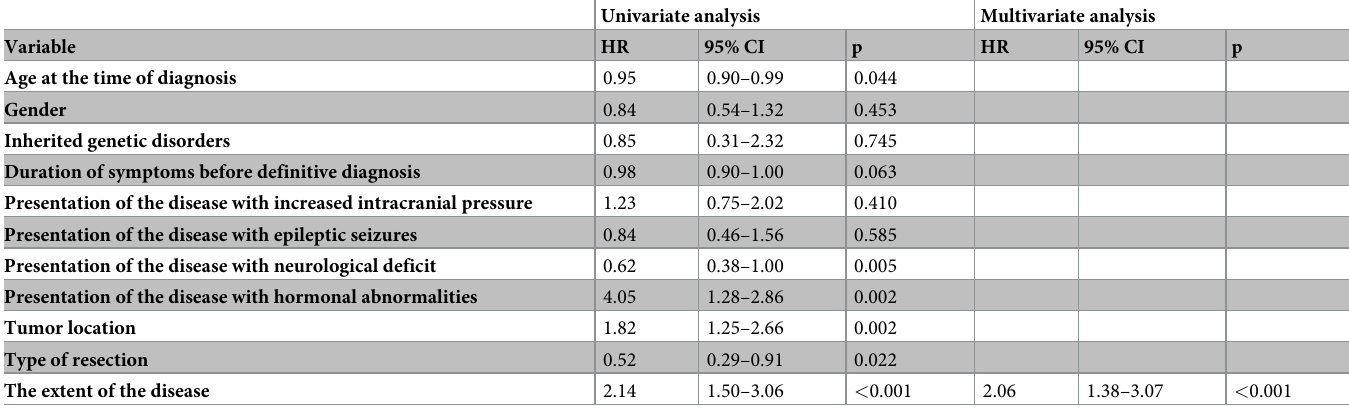
Table 2. Predictive factors of OS in 173 pediatric patients with brain tumors–Cox proportional hazard regression